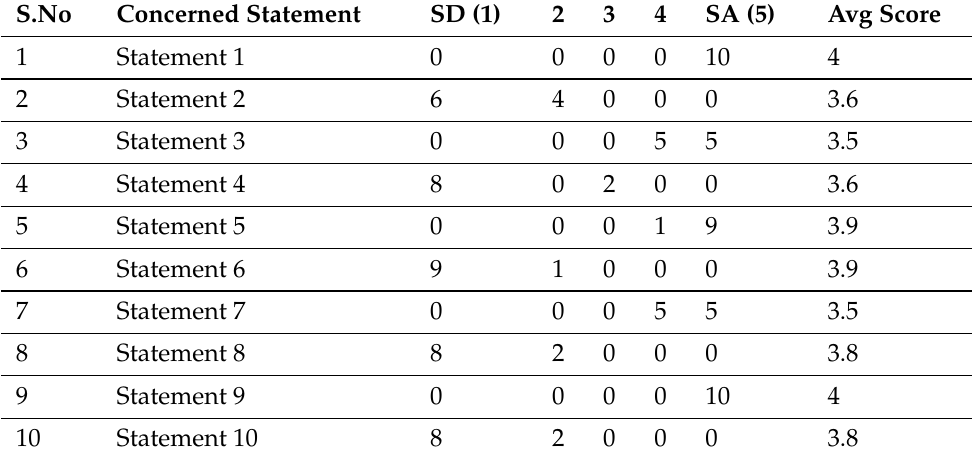
Table 2. SUS Results of G3 (GRA-PIN authentication application users). Average SUS Score = 37.6, Total SUS Score = 37.6 × 2.5 =